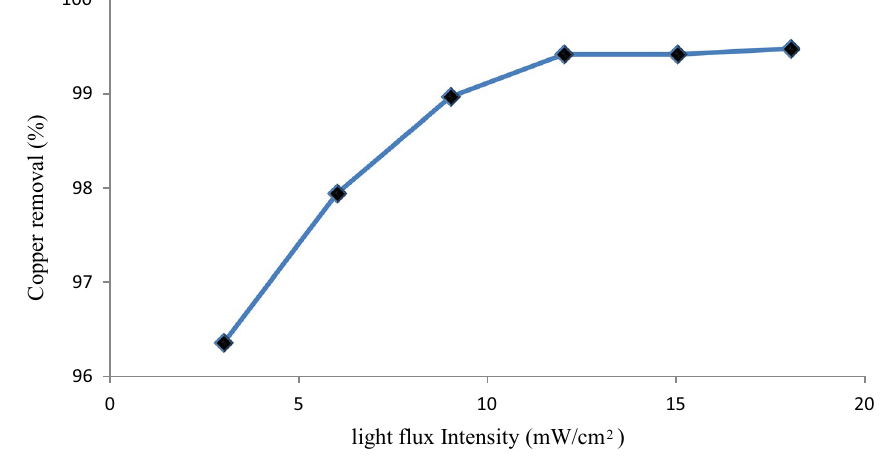
Fig. 8 The kinetic of Cu 2+ reduction on the hetero-system CuFeO 2 –ZnO. Inset: the plot ln C C t / o versus